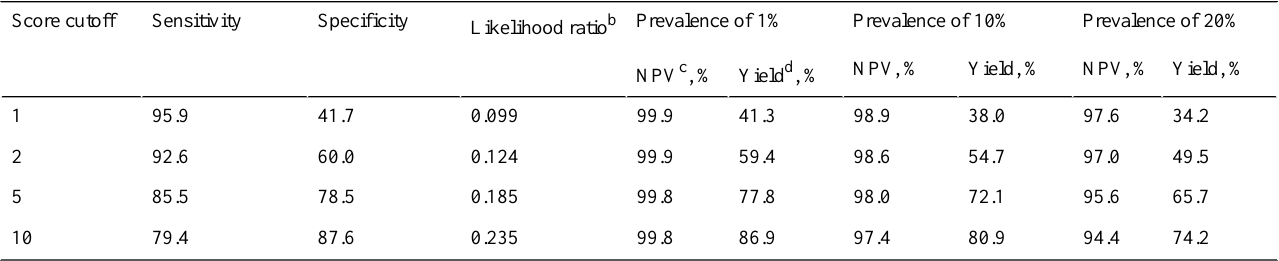
Table 2. Clinical performance metrics for the model in the external validation data set for various score cutoffs and COVID-19 pretest prevalence a .